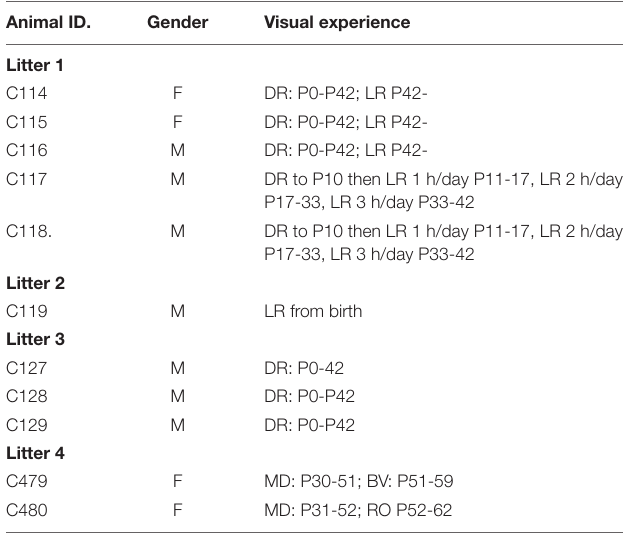
TABLE 1 | Information concerning the litter composition, gender and rearing history of the 11 animals of the study. Animal